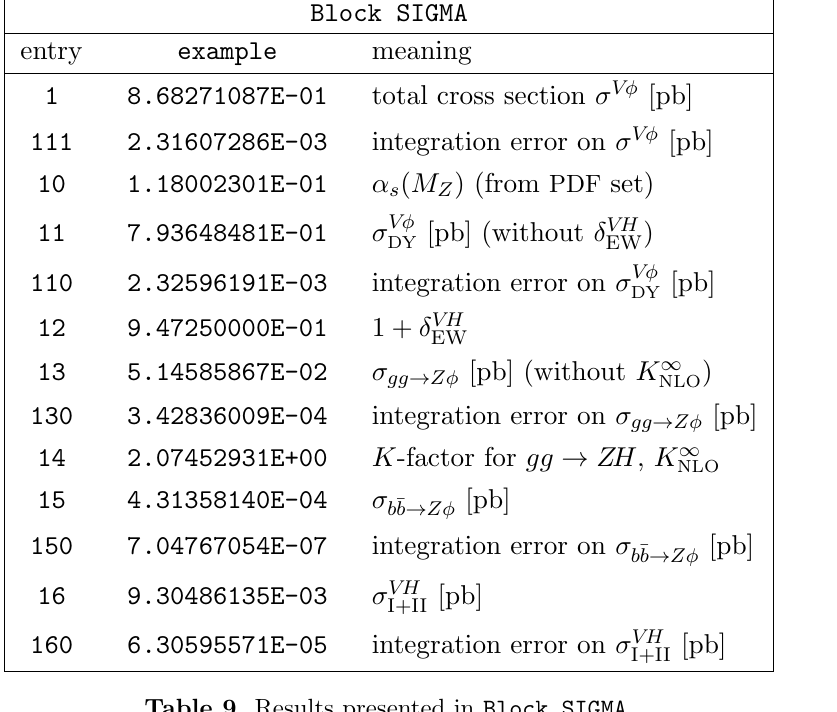
Table 9 . Results presented in Block SIGMA .